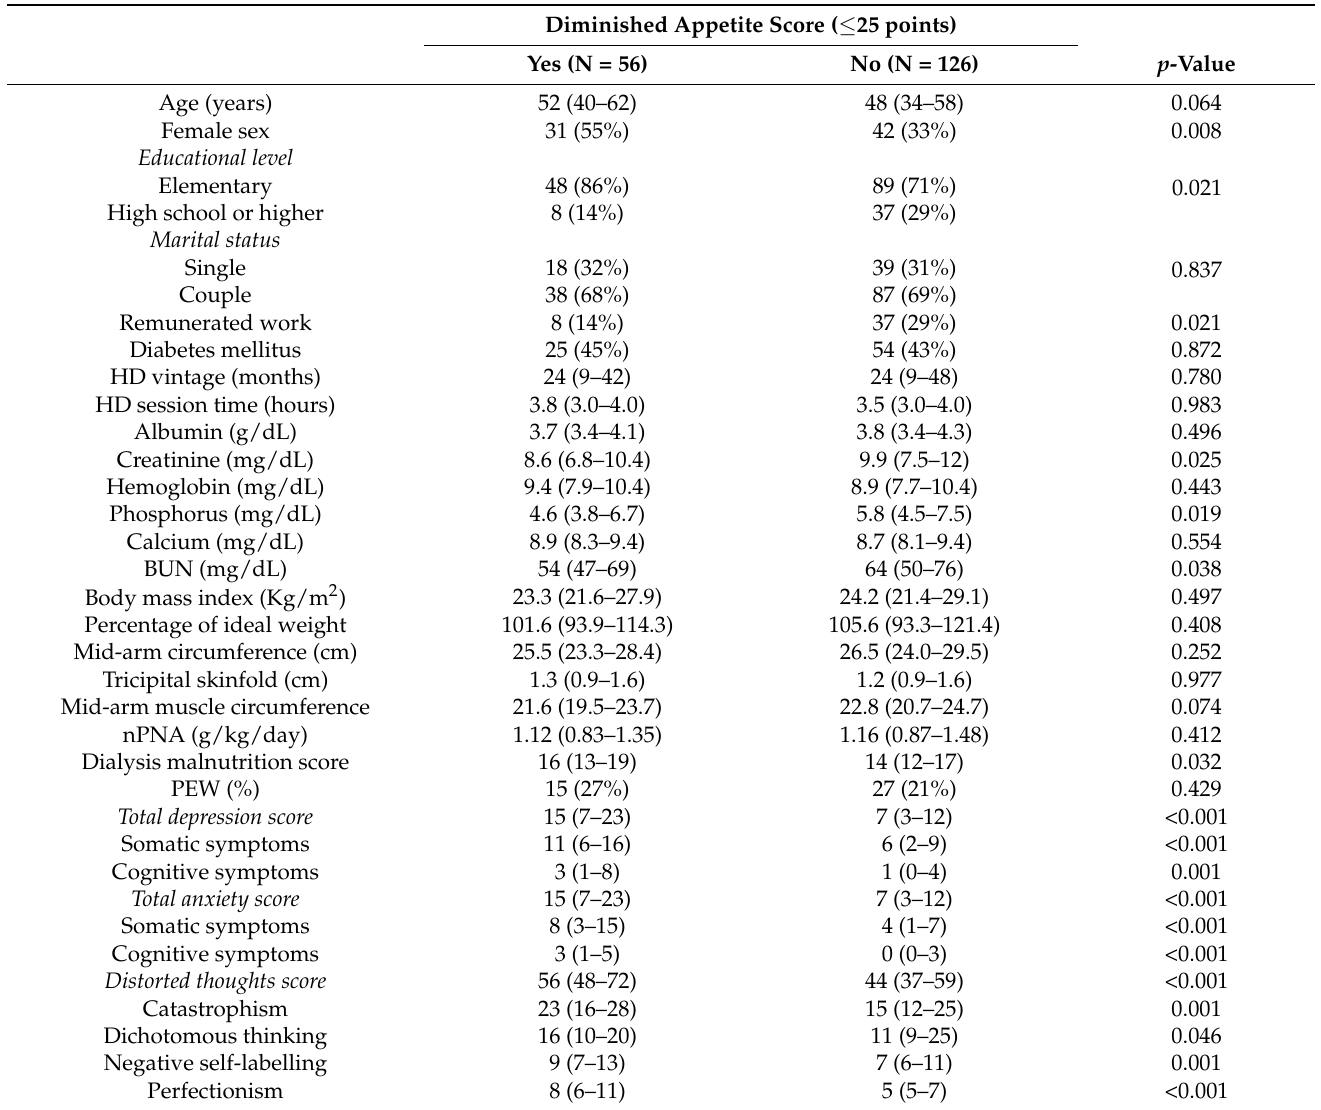
Table 4. Anthropometric variables, laboratory results, dialysis malnutrition scores, and psychological variables compared by appetite level in 182 ESRD patients treated with chronic